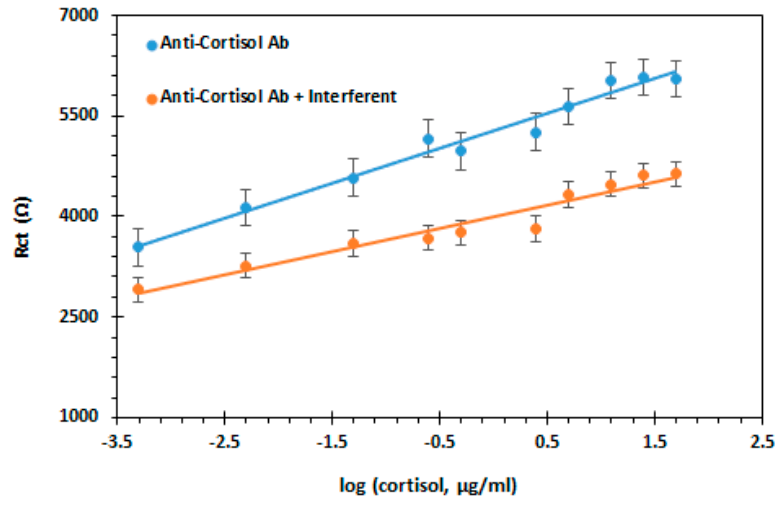
Figure 6. Calibration curve of cortisol and of progesterone interference.